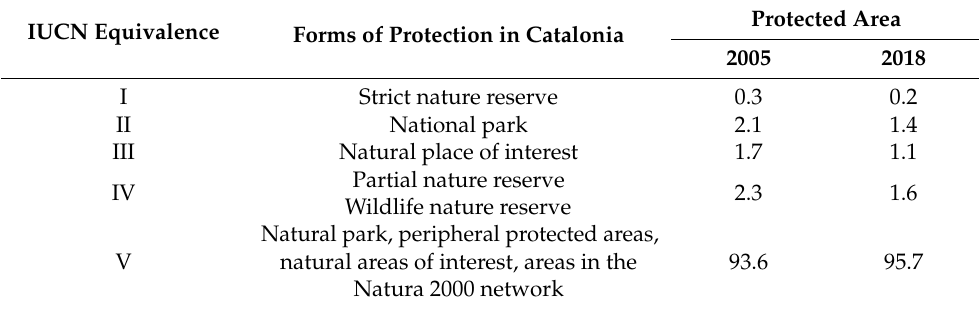
Table 17. Equivalence between the forms of protected natural areas in Catalonia and the categories of IUCN protected areas. Source: Catalan Institution of Natural History (2018). IUCN Equivalence Forms of Protection in